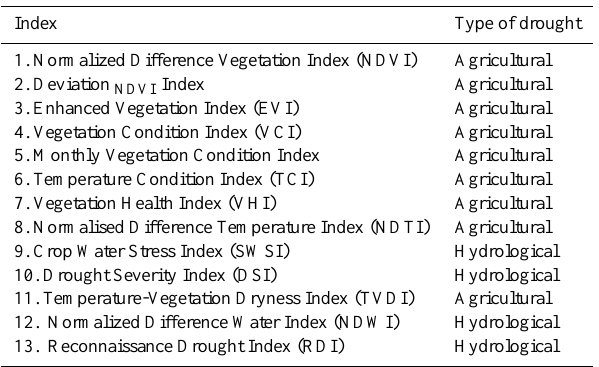
Table 1. Satellite-based drought indices and corresponding drought type.